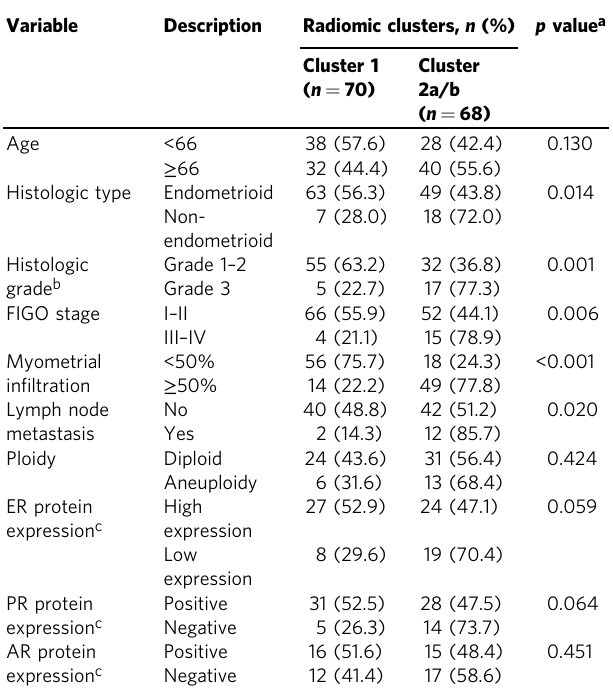
Table 1 Clinico-pathological variables in relation to the radiomic clusters based on the manually segmented tumors ( n =